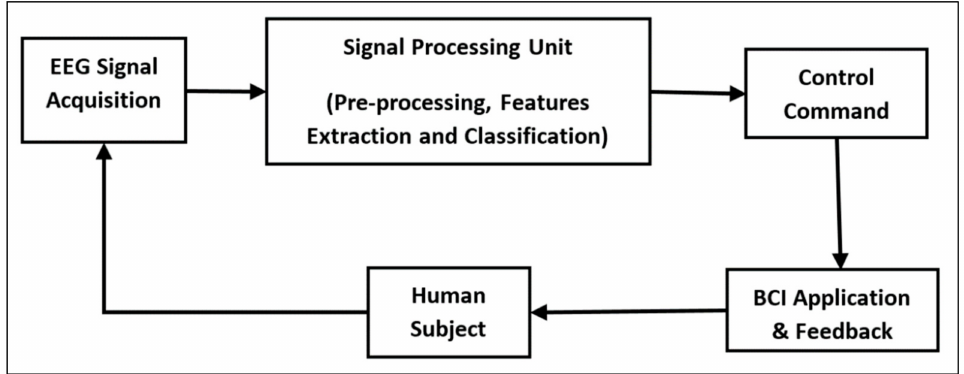
Figure 1. Standard BCI